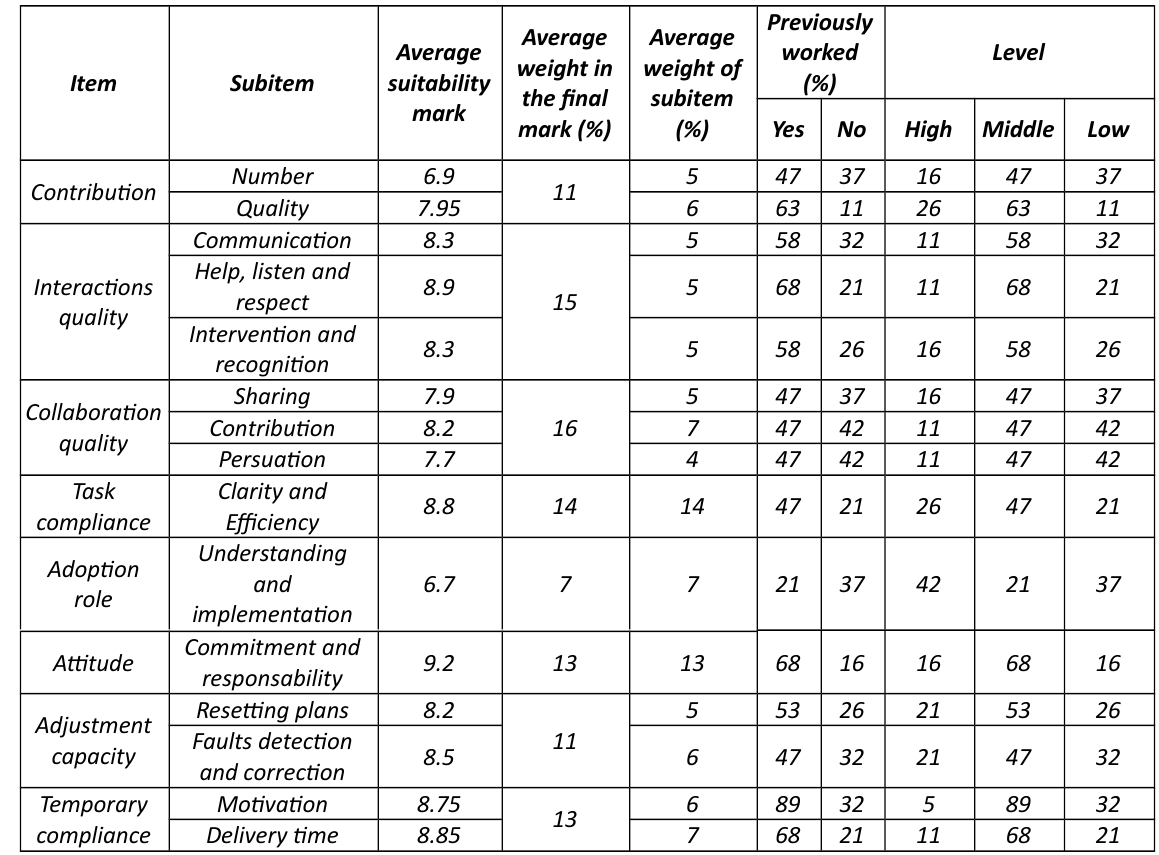
Table 6. Analysis of the results of the validaton of the rubric for teamwork skills